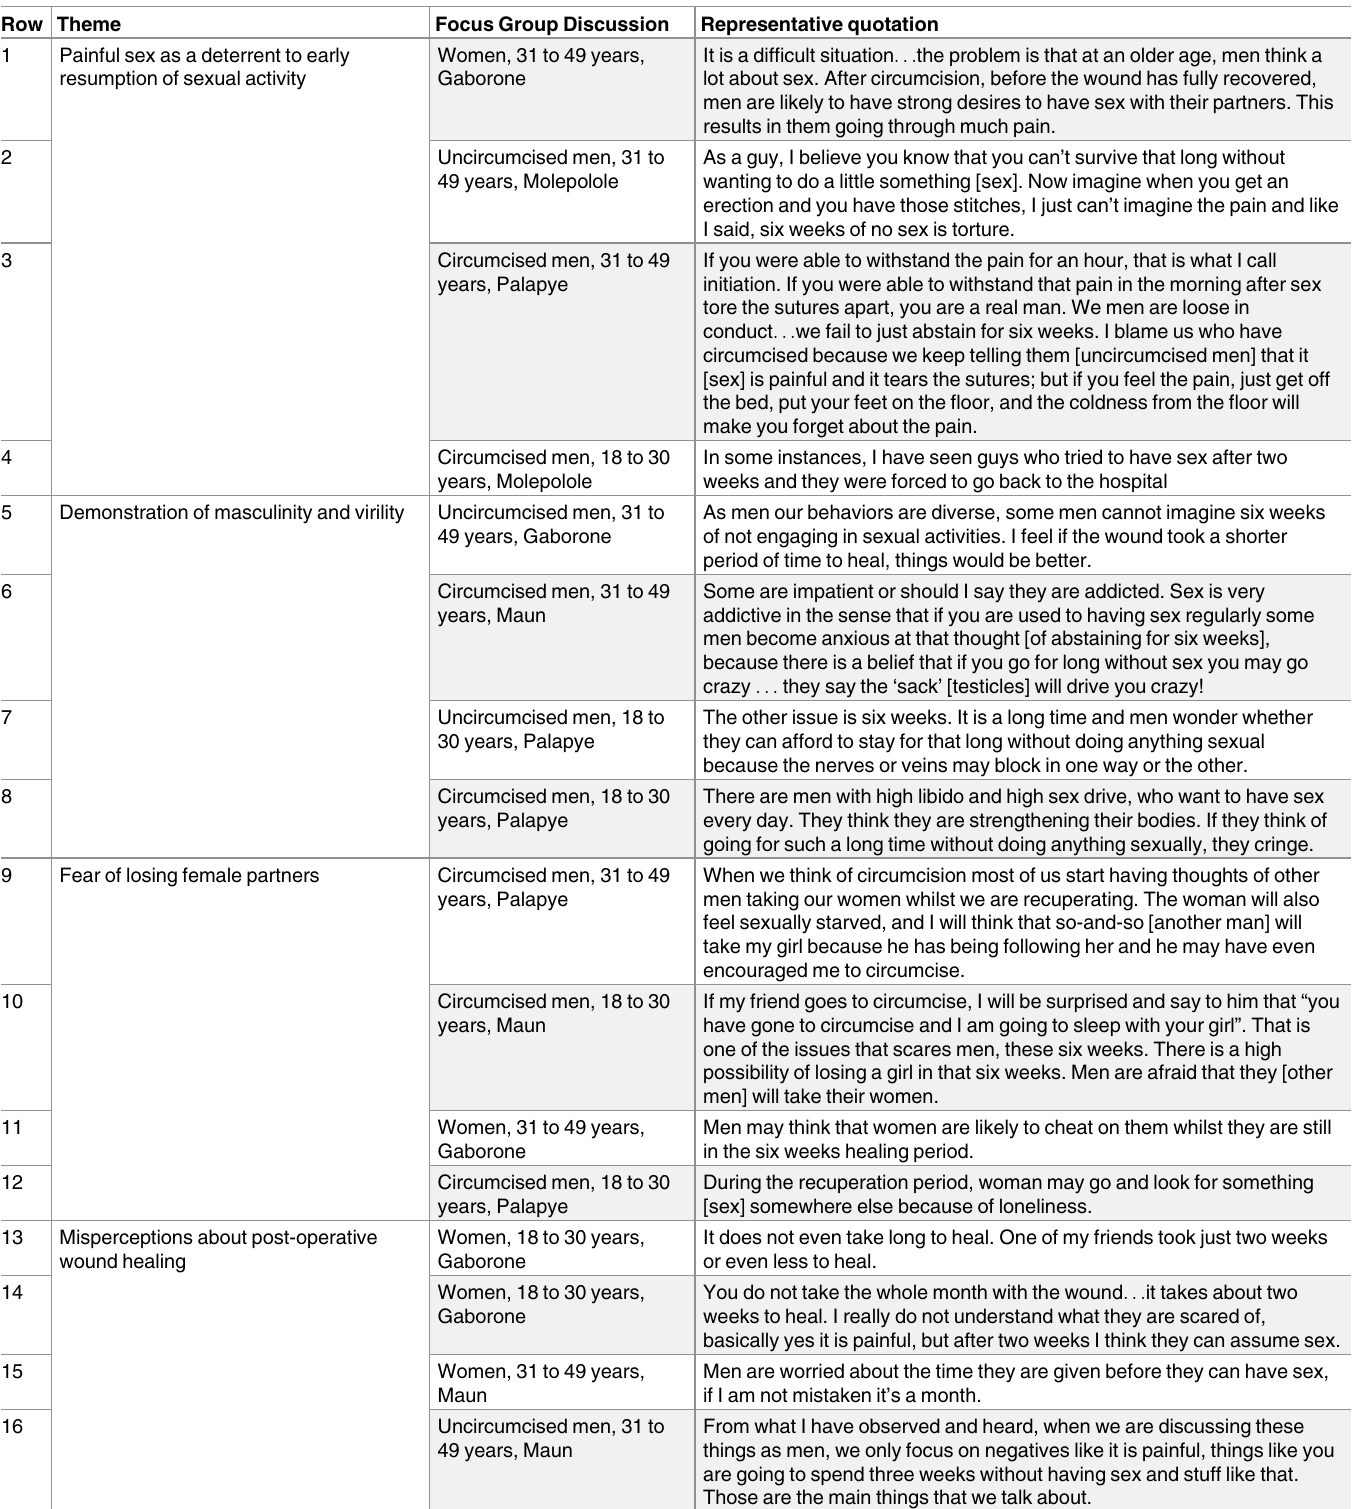
Table 2. Early resumption sex following voluntary medical male circumcision (VMMC) from the perspectives of 238 men, women, and community leaders in four communities in Botswana. Row